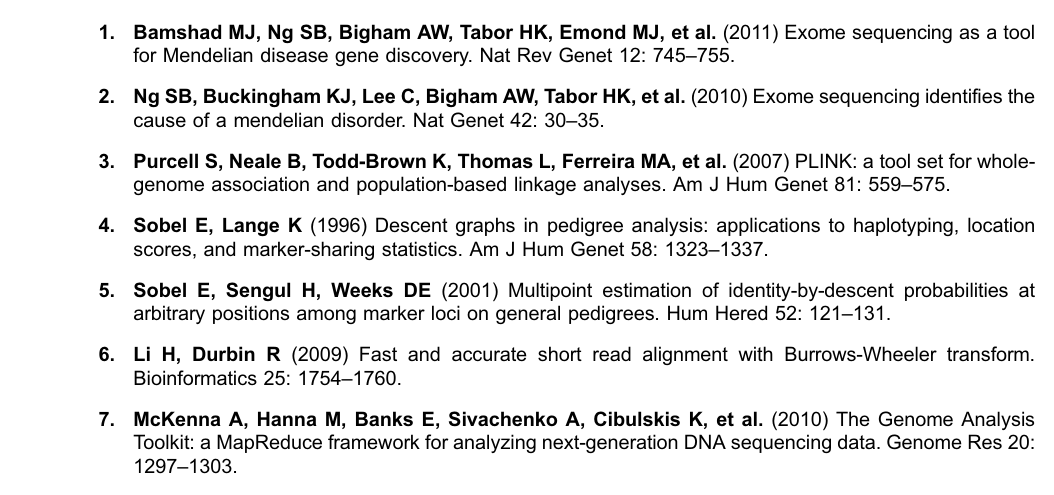
Table S1 . 216 candidate genes for neurological diseases. Table S2. List of nonsynonymous variants identified in four exome-sequenced individuals that are rare ( , 1%) or absent in all 1000 genomes populations or the exome variant server database in 216 known neurological and neuromuscular disease genes. Text S1. Clinical Case